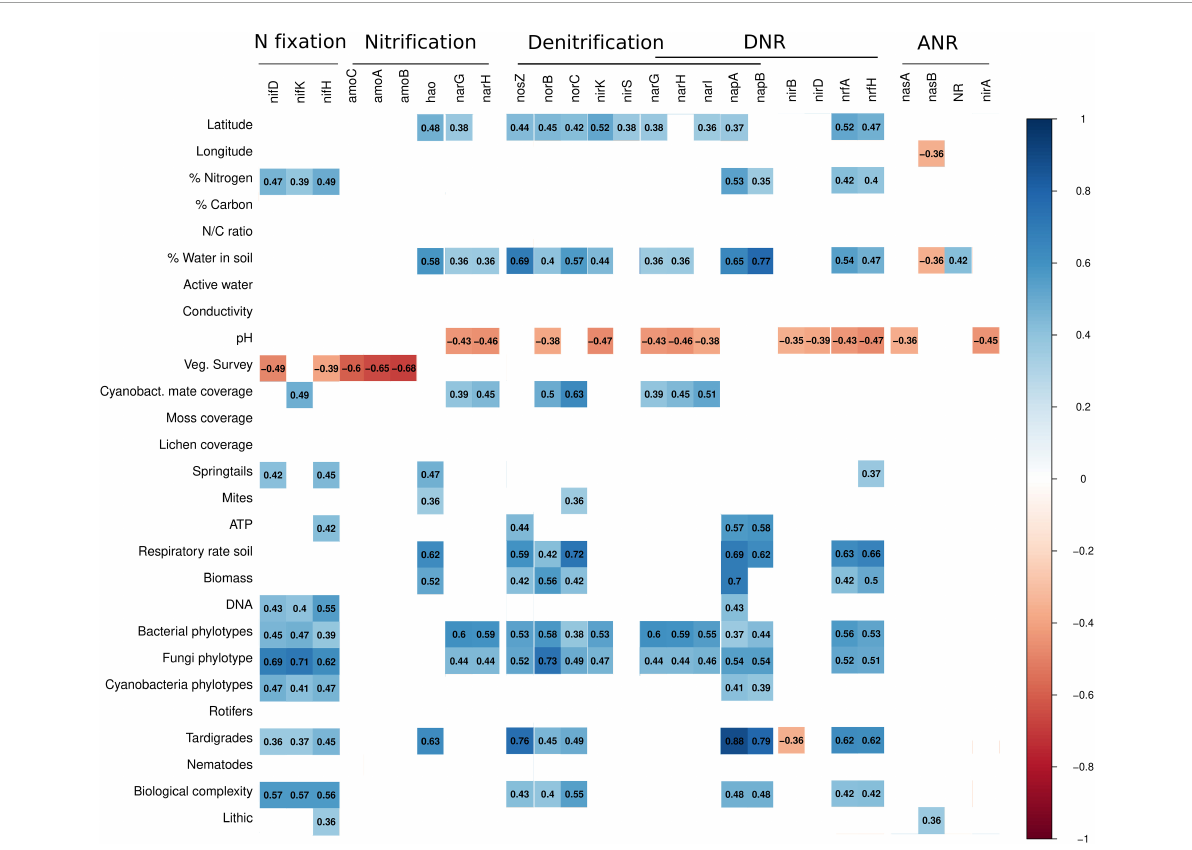
FIGURE5 Gene richness with biogeochemical variables correlation. The red gradient indicates negative correlation (down to -1), while the blue gradient indicates positive correlation (up to +1). Non-significant ( p > 0.05) correlations were not